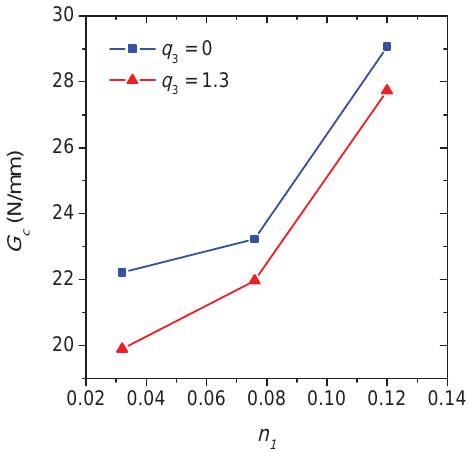
Figure 14. The critical energy release rate G c versus the strain hardening exponent n 1 curves for two different values of q 3